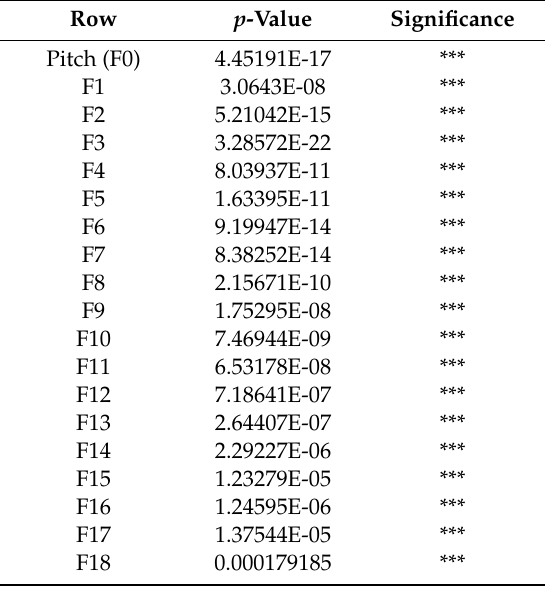
Table 2. Significance levels obtained by the OLS model considering the analysed audios. Row p